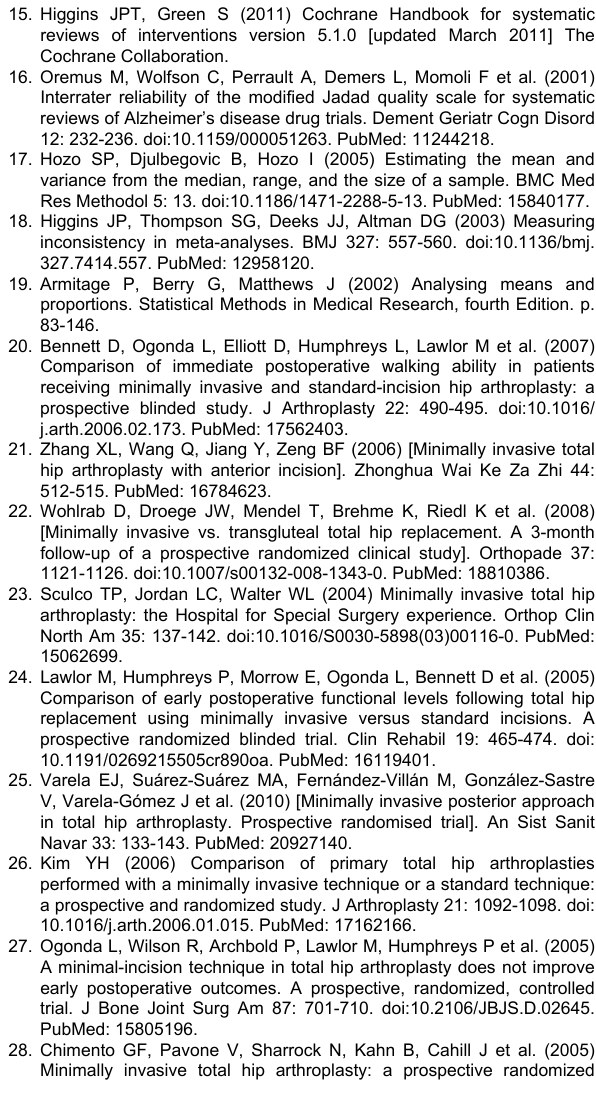
Table S2. Modified Jadad Scale with eight